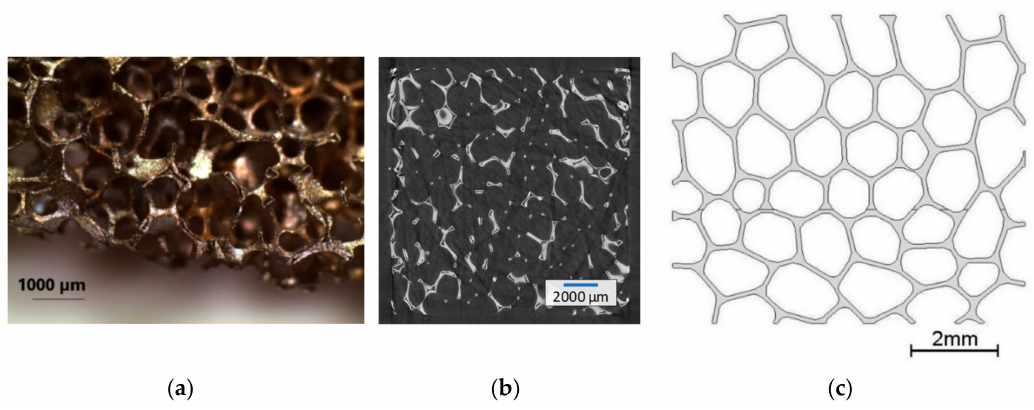
Figure 2. Austenitic stainless steel cellular material ( a ); one slice of a µ CT-analysis of the open-cell cellular material 1.4841, 45 ppi ( b ); 2D model used in the finite element (FE) simulation, based on the stainless steel material ( c